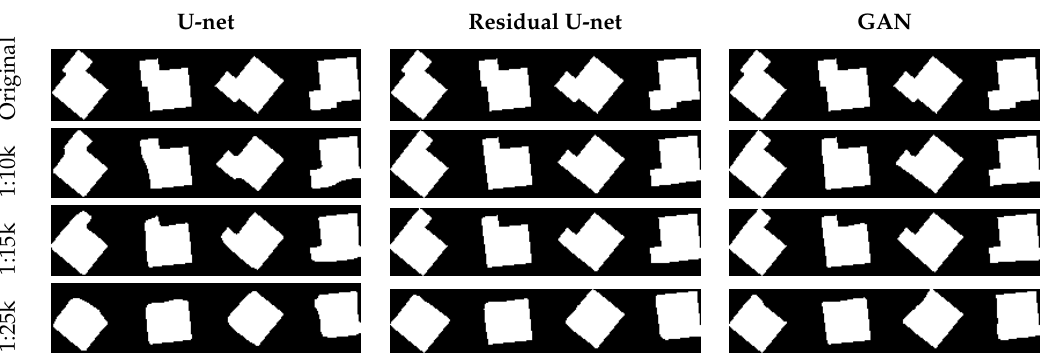
Figure 13. Evaluation of different models on buildings with orientations at three target map